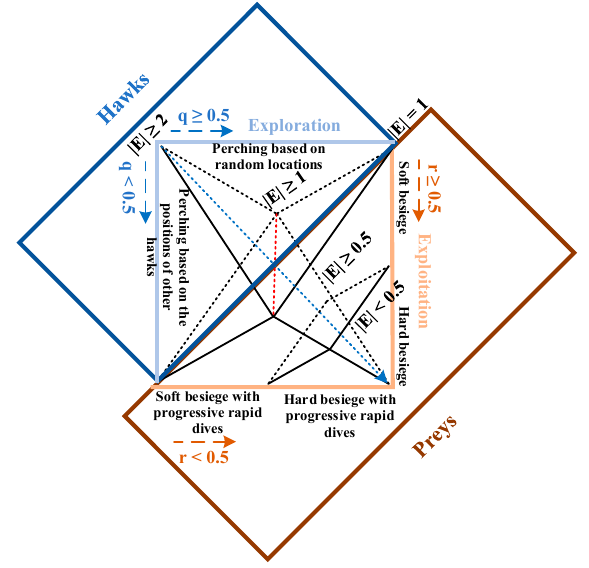
Figure 3. HHO hunting modes.